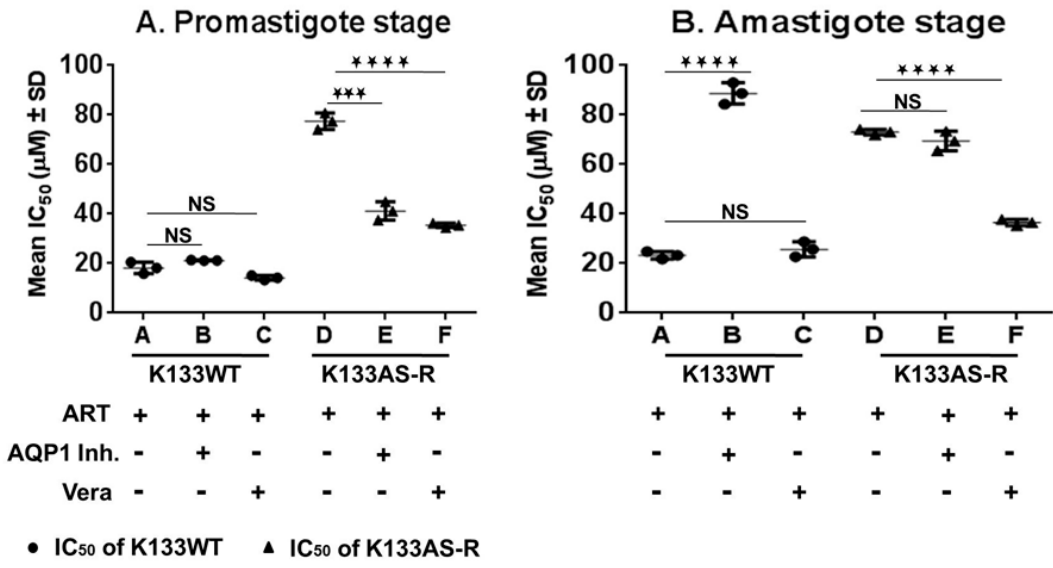
Figure 8. Susceptibility of K133WT / K133AS-R isolates in the presence of the AQP1 inhibitor or the modulator to ABC transporter, verapamil. In vitro susceptibility of the sensitive wild-type strain K133 WT / artemisinin-resistant strain K133AS-R isolates towards artesunate in the presence of the AQP1 inhibitor (AQP1 Inh.) and verapamil (Vera) at ( A ) the promastigote stage and ( B ) amastigote stage. IC 50 ± SD of three independent experiments in duplicates is represented here. *** represents p ≤ 0.001, **** represents p ≤ 0.0001, NS represents not significant, Circle represents IC 50 of K133WT, Triangle represents IC 50 of K133AS-R.